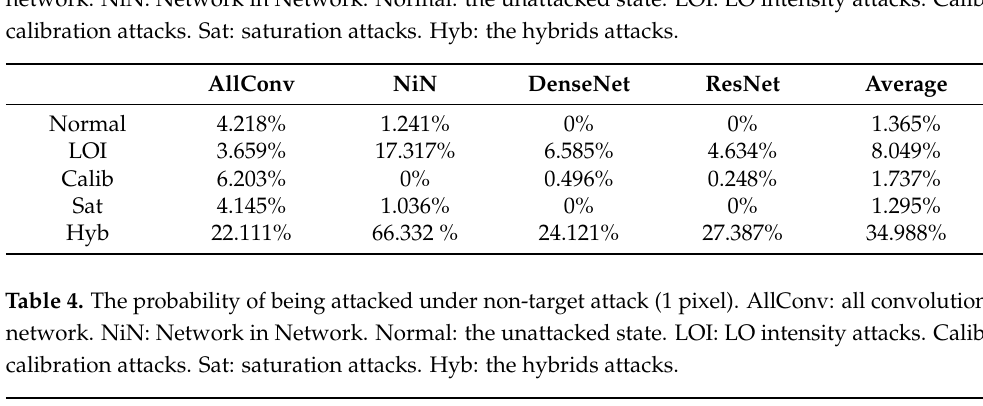
Table 3. The probability of being mistaken under target attack (1 pixel). AllConv: all convolution network. NiN: Network in Network. Normal: the unattacked state. LOI: LO intensity attacks. Calib: calibration attacks. Sat: saturation attacks. Hyb: the hybrids attacks. AllConv NiN DenseNet ResNet Average Normal LOI Calib Sat